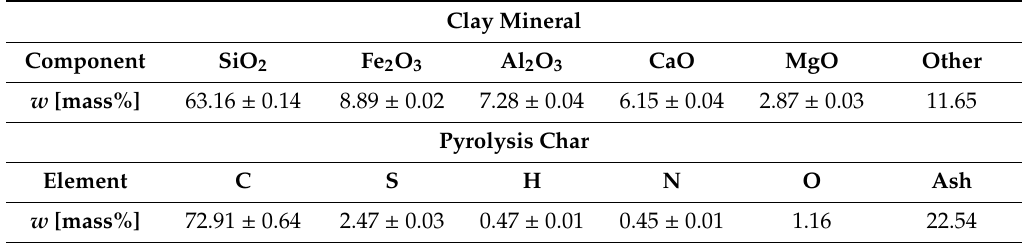
Table 1. Clay mineral chemical composition [16] and pyrolysis char elemental composition.